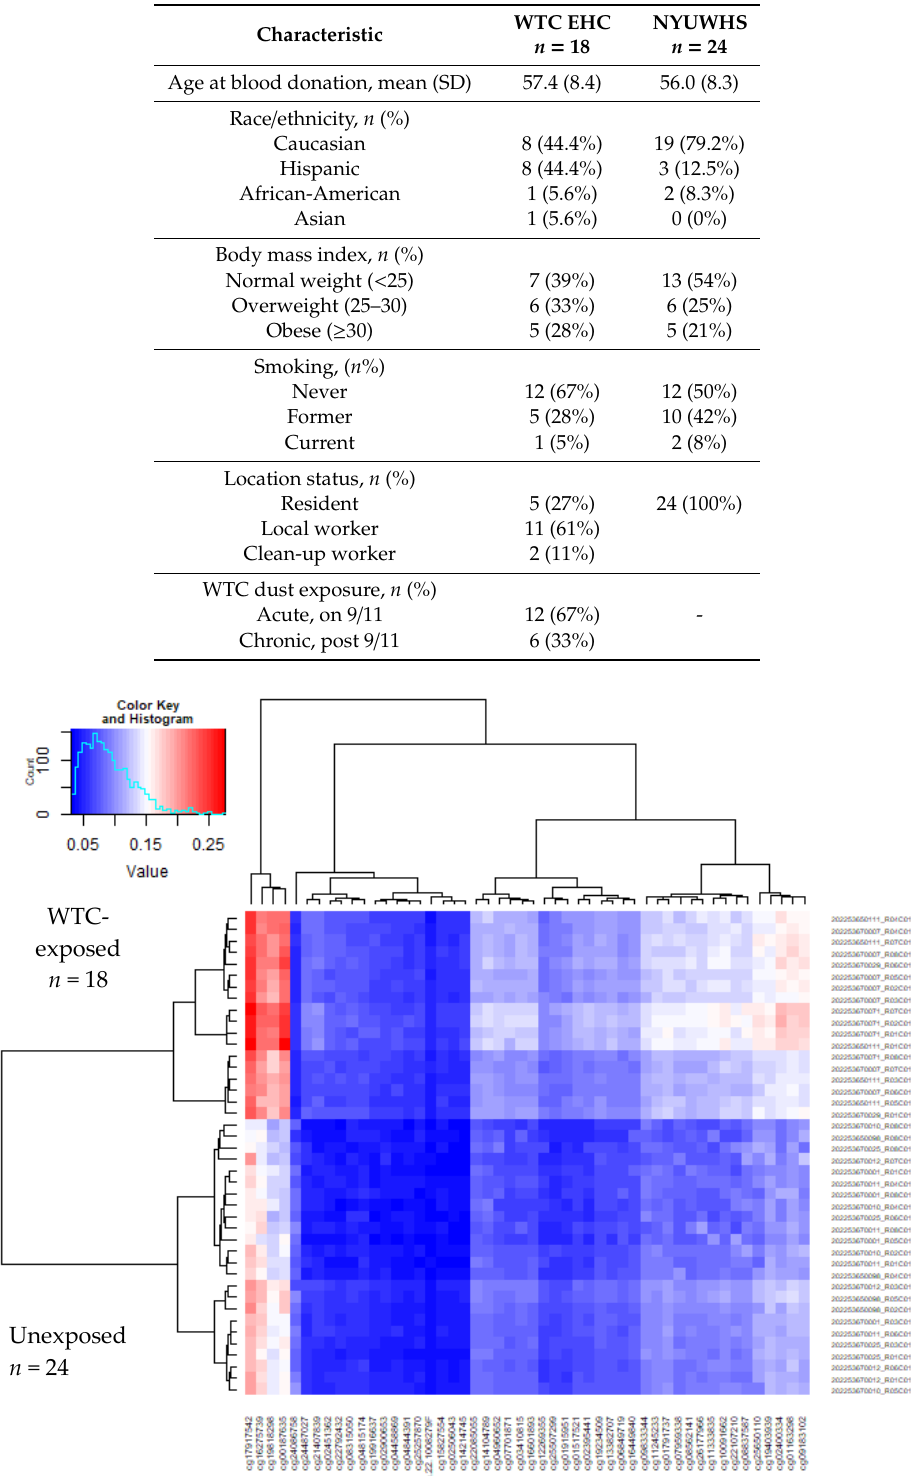
Table 1. Descriptive characteristics of the WTC-exposed (WTC EHC) and unexposed (NYUWHS) cancer-free subjects.